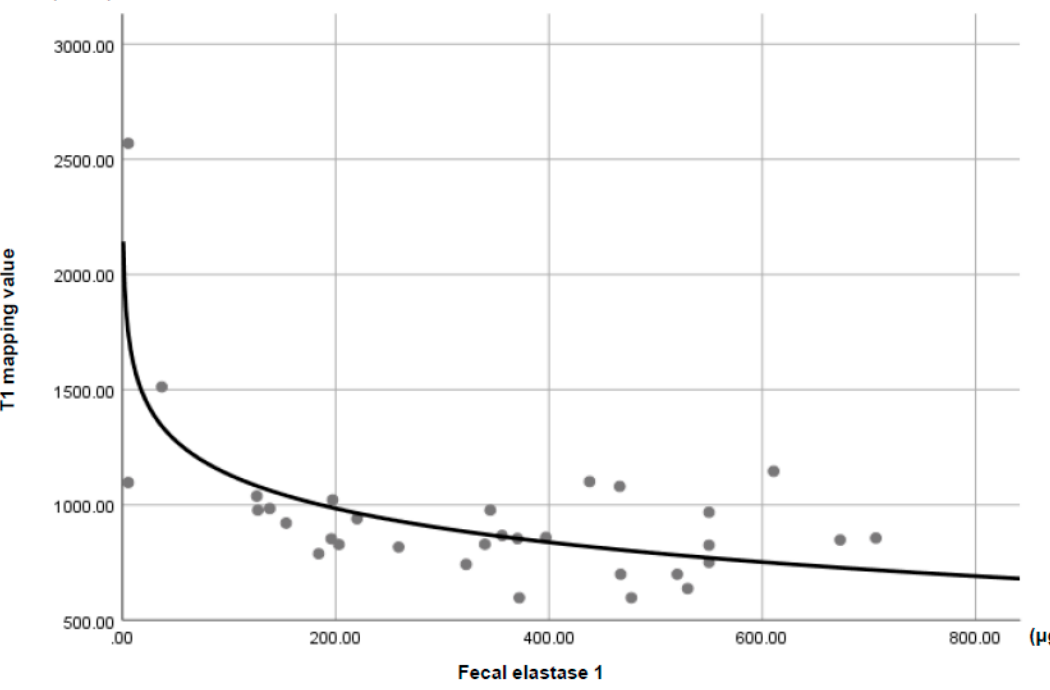
Figure 1. A significant correlation was seen between the T1 mapping values and fecal elastase 1 ( r = ‐